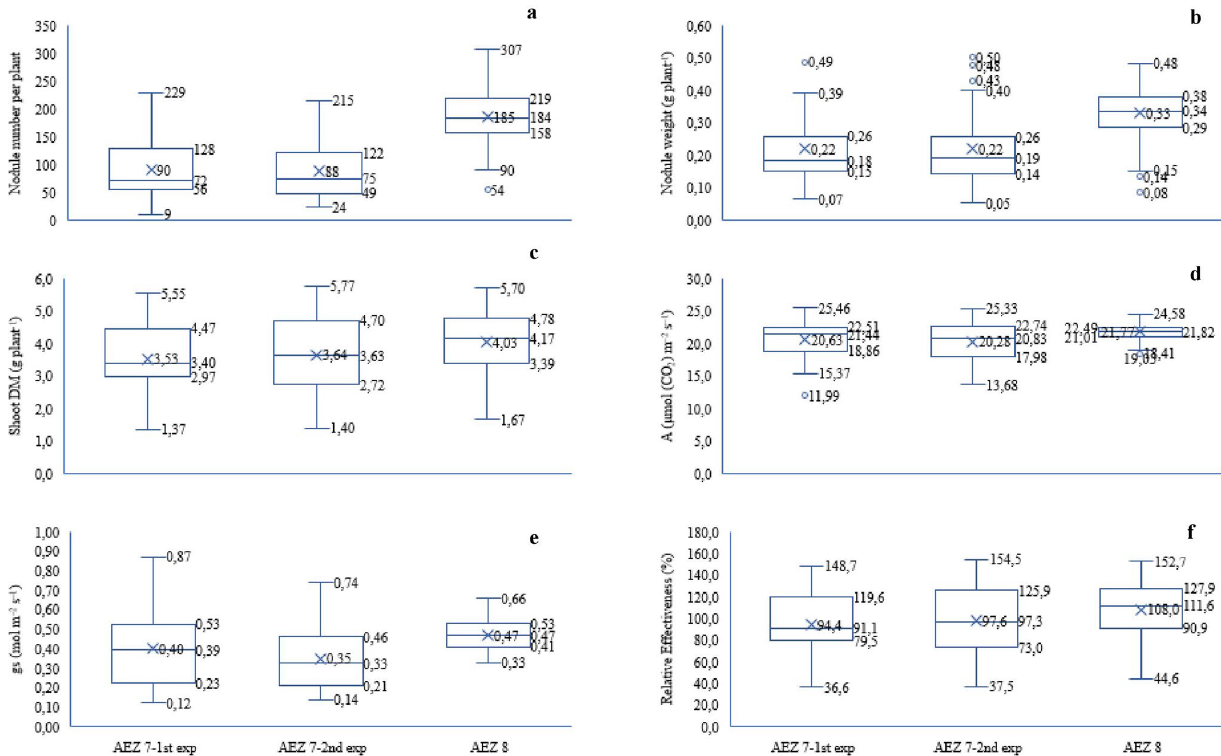
Figure 5. A Box and whisker plot analyses of the variability in nodulation, shoot biomass and photosynthetic physiology of cowpea inoculated with native rhizobial isolates from AEZ 7 and AEZ 8 of the Nampula Province, Mozambique. Centre lines indicate the median; X indicates the mean while box limits indicate the lower and upper quartiles; outliers are indicated by